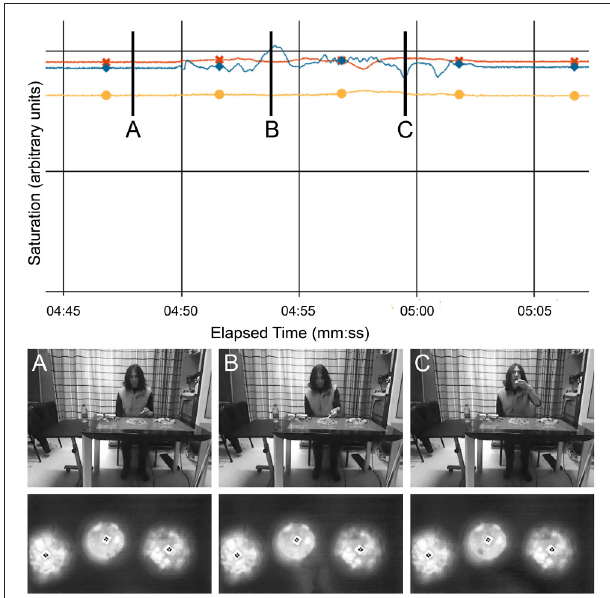
FIGURE 1 | Comparison of saturation measurements with Kinect and SUR40 videos. The blue line with diamond markers, which shows the most fluctuation, corresponds to the central plate in the video frames. The frames are labeled (A–C) corresponding to the times of the vertical markers in the graph. Frame A takes place before the start of a bite—note that the saturation remains steady while there is no interaction with the surface. Frame B takes place as the food is being picked up with the fork. Note that the saturation has reached a peak here, corresponding to the increase in brightness in the bottom-right area around the plate, as visible in the SUR40 frame. Frame C takes place as the food is being placed in the mouth. Note that there is a slight shadow as compared to Frame A in the region to the bottom-right of the plate, corresponding to the local